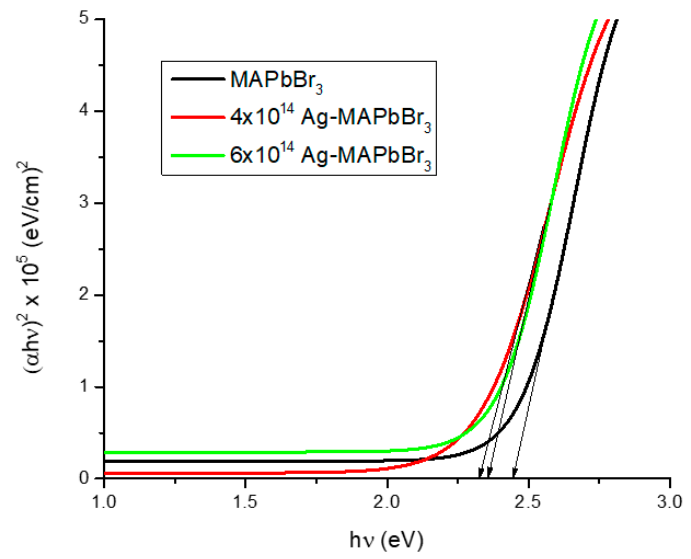
Figure 6. E g of MAPbBr 3 and Ag-irradiated MAPbBr 3 thin films.